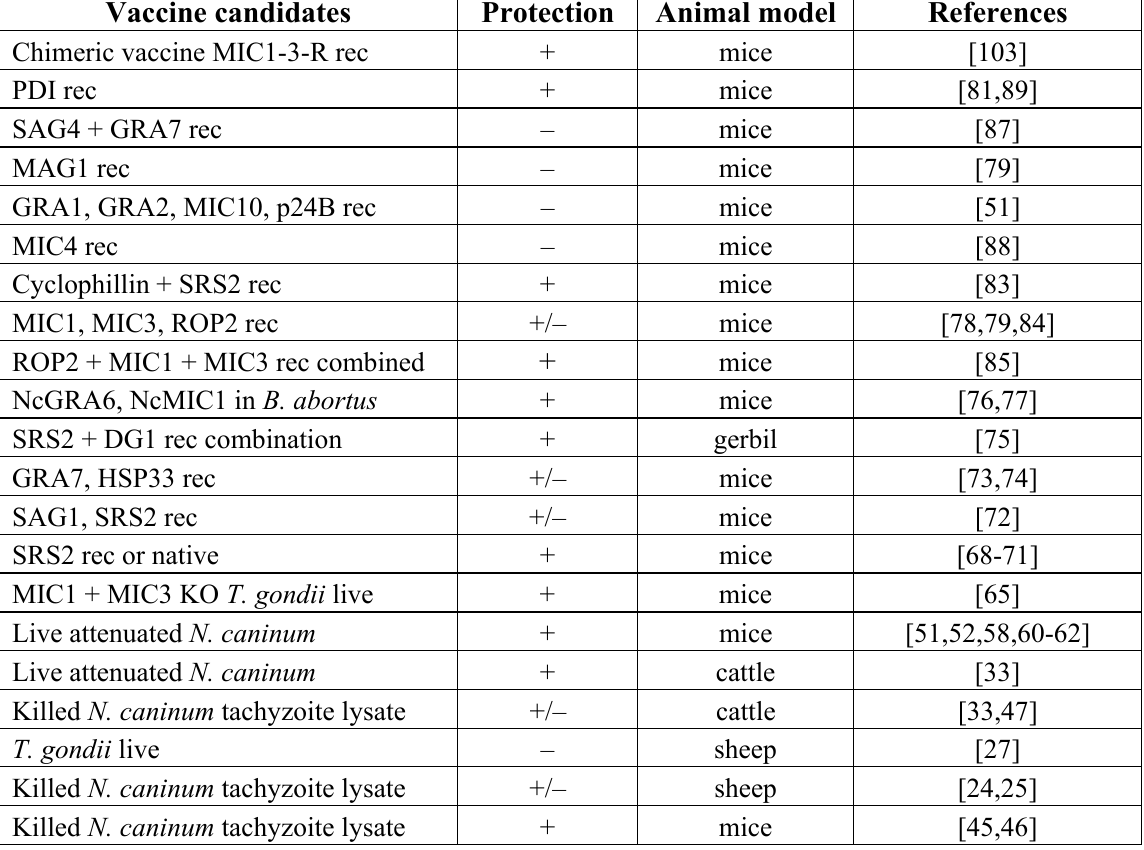
Table 1. Summary of vaccine candidates (killed lysates, live-attenuated, recombinant subunit vaccines) and animal models investigated for the prevention of N. caninum